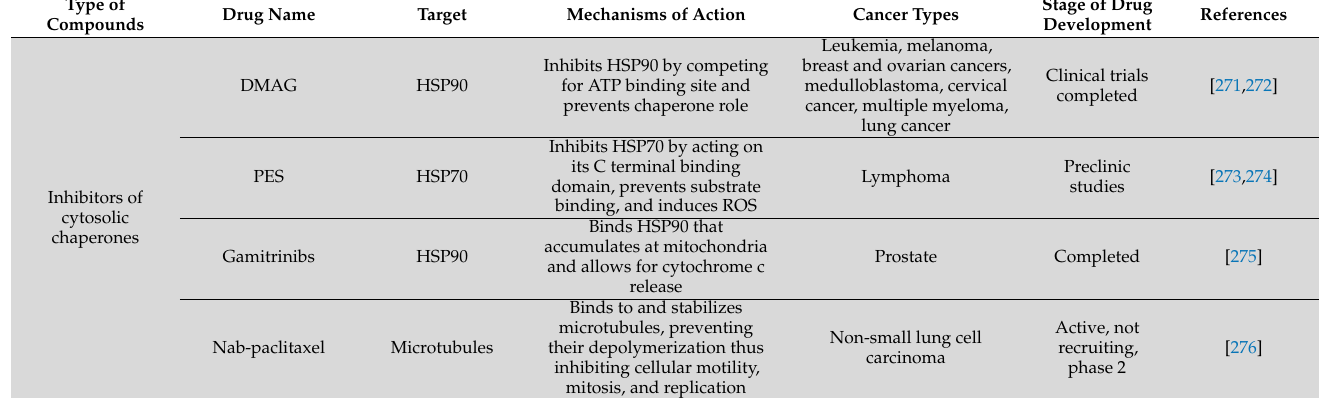
Table 2. Compounds targeting MPQC players in